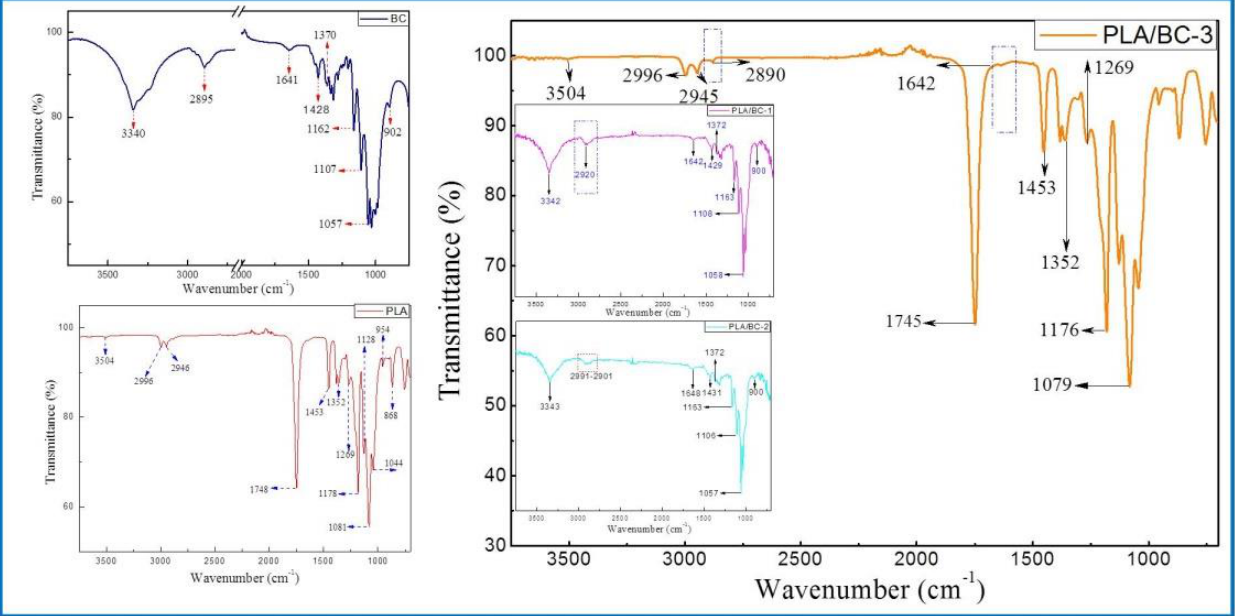
Figure 3. FTIR spectra of BC (left) and 3D − printed PLA/BC scaffolds (right). The ATR-FTIR spectra of the BC demonstrated typical spectral peaks. The -OH stretching and bending was located at around 3340 cm − 1 , -CH 2 bending vibrations were at 1428 cm − 1 , and the C-H stretching and bending appear at 2895 cm − 1 and 1370 cm − 1 . The bands at 1170–1050 cm − 1 (1162 cm − 1 , 1107 cm − 1 and 1057 cm − 1 ) were ascribed to the vibrations of C-O-C bonds of the glycosidic bridges. The absorption bands at 902 cm − 1 were characteristic of β -linked glucose-based polymers. Finally, the peak at 1641 cm − 1 was assigned to the H-O-H in-plane deformation vibration of absorbed water by the BC. All the characteristic peaks corresponded to those of the BC, which indicated that BC was with the literature